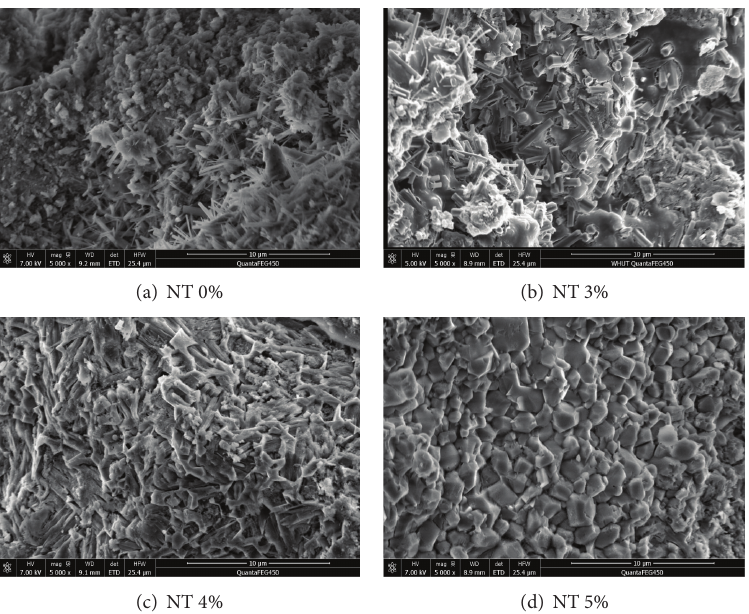
Figure 4: SEM images of mortars with NT at 28 days.